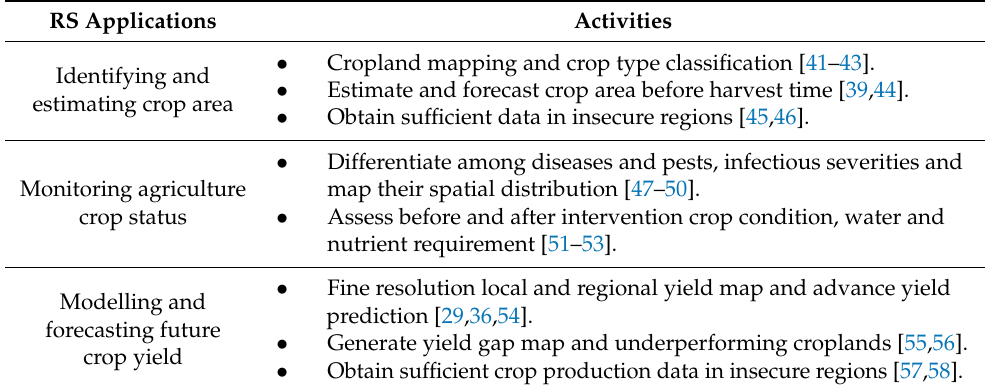
Table 1. The role of remote sensing for monitoring agricultural productivity and increasing food